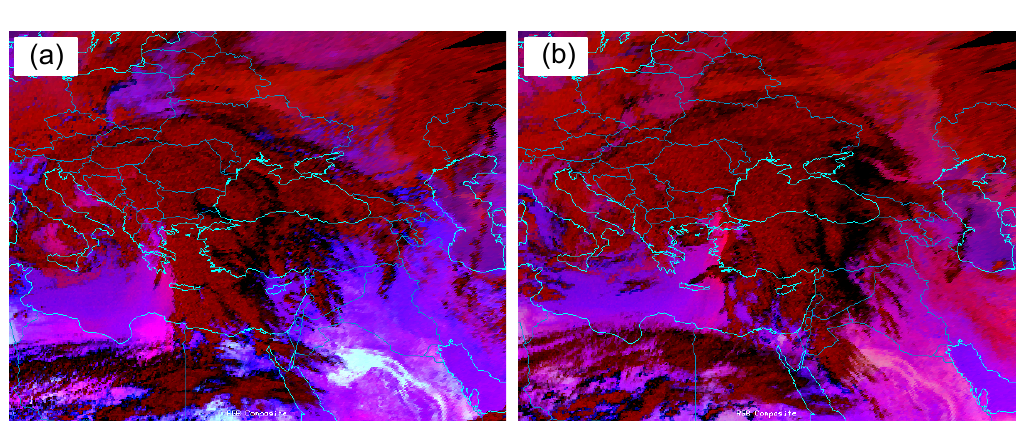
Figure 7. Dust product for ( a ) 12:00 UTC and ( b ) 18:00 UTC on 23 March 2016, derived from three infrared channels of the SEVIRI imager on Meteosat-10, with center wavelengths at 12.0, 10.8, and 8.7 µm. This false-color image was created using an algorithm from EUMETSAT, which colors red the difference between the 12.0 and 10.8 µm channels, green the difference between the 10.8 and 8.7 µm channels and blue the 10.8 µm channel. Dust appears pink or magenta, water vapor dark blue, thick high-level clouds red-brown, thin high-level clouds almost black and surface features pale blue or purple.